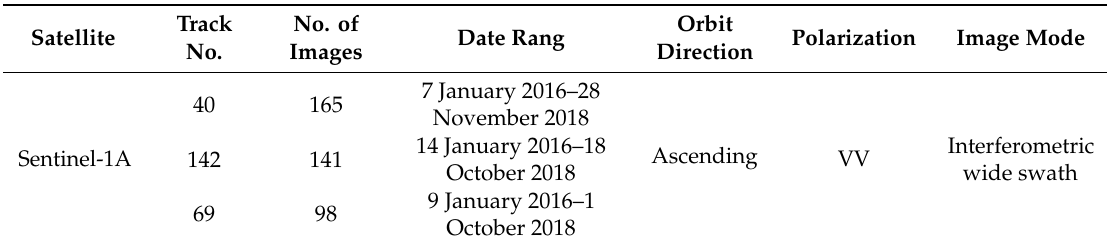
Table 2. Satellite information for the data used in this